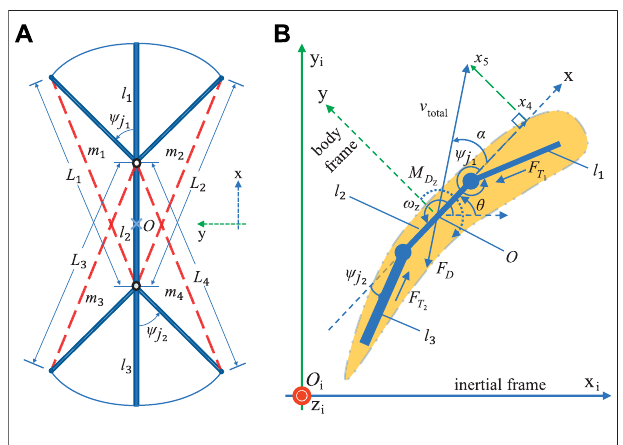
FIGURE 4 | Robotic fi sh modeling. (A) Geometric model schematic; (B) dynamic model schematic.